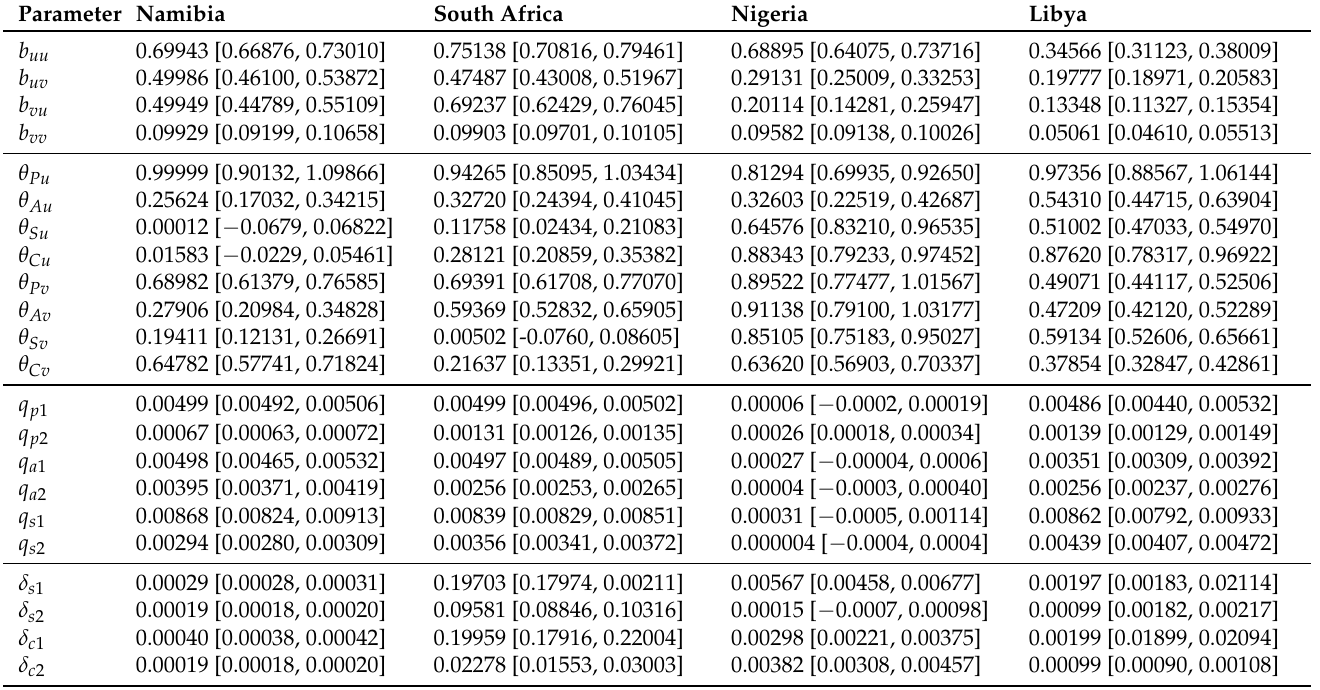
Table A5. Estimated (fitted) parameter values and their 95% CI for the model for each selected